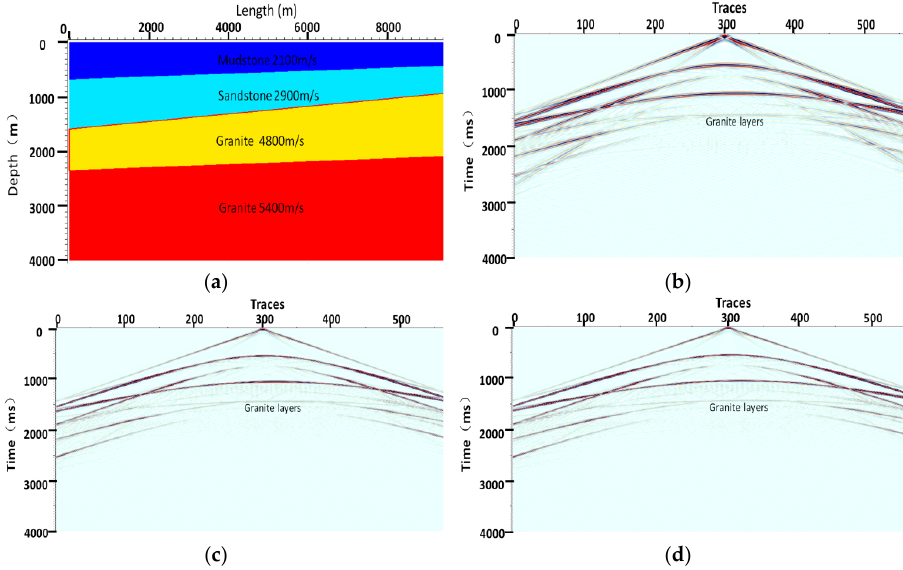
Figure 4. The theoretical model ( a ) (the geometry is 2990 ‐ 5 ‐ 10 ‐ 5 ‐ 2990) and the 3 Hz ( b ), 15 Hz ( c ) and 30 Hz ( d ) dominant frequency forward modeling seismic records.